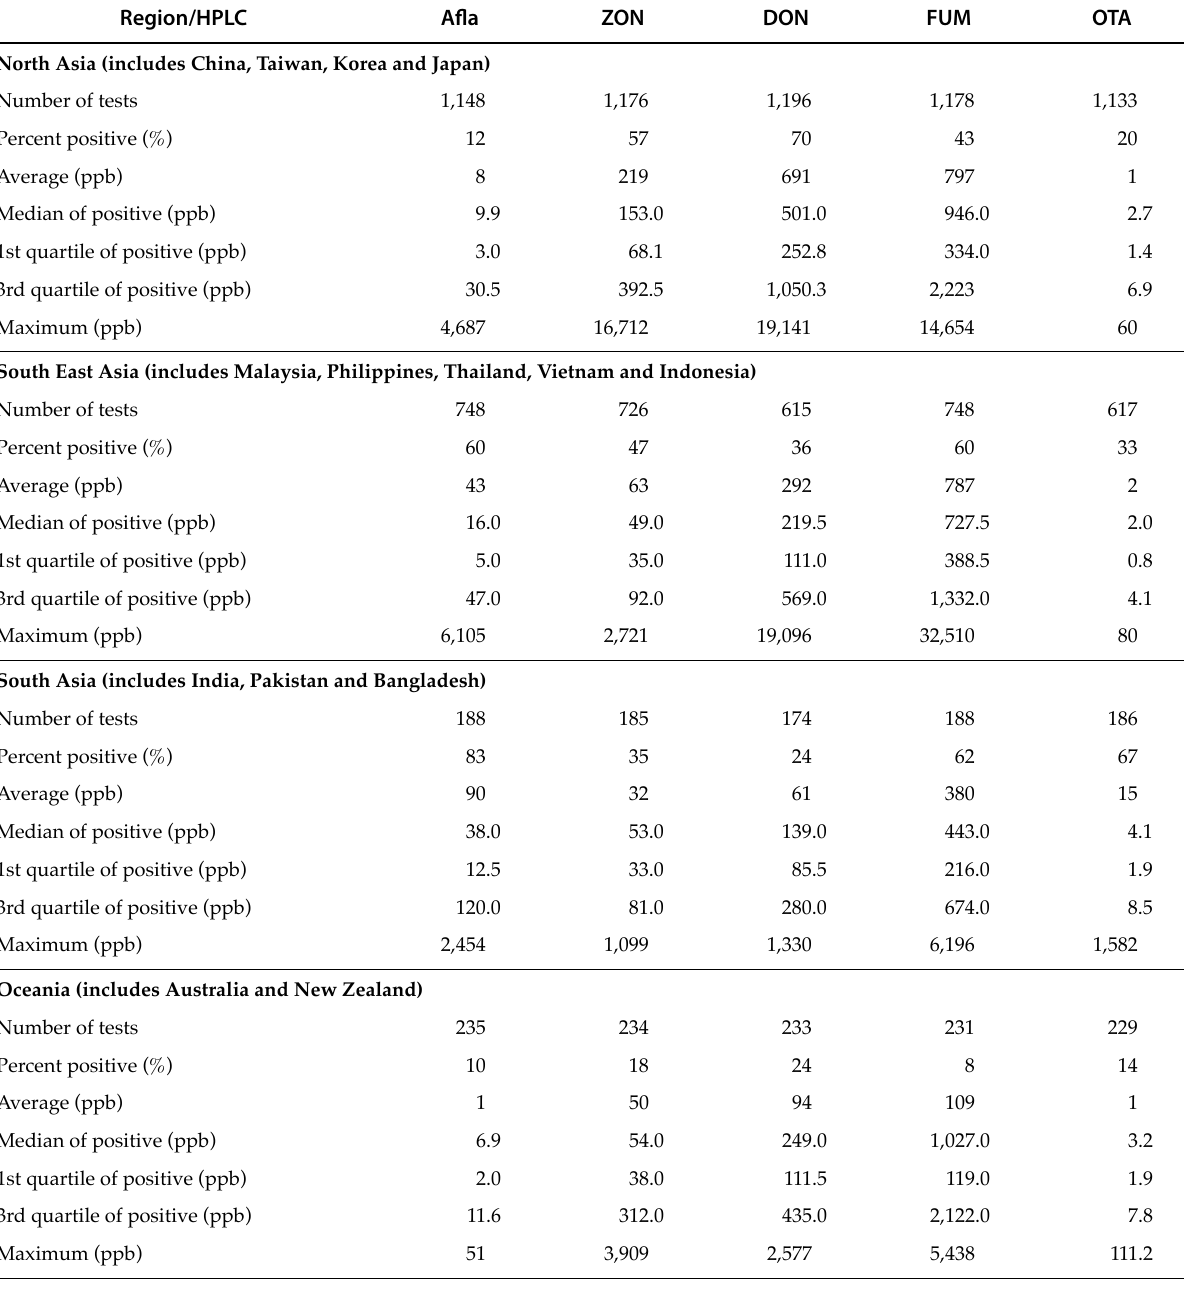
Table 4. Survey results by geographic region (Asian region, HPLC). Region/HPLC Afla ZON DON FUM